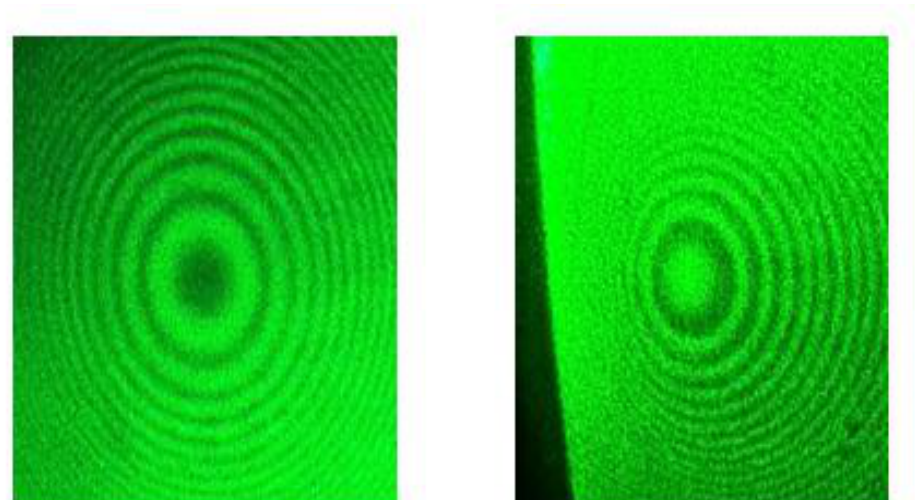
Fig. 2: Newton’s rings pattern in the reflected beam (left) and the transmitted beam (right).